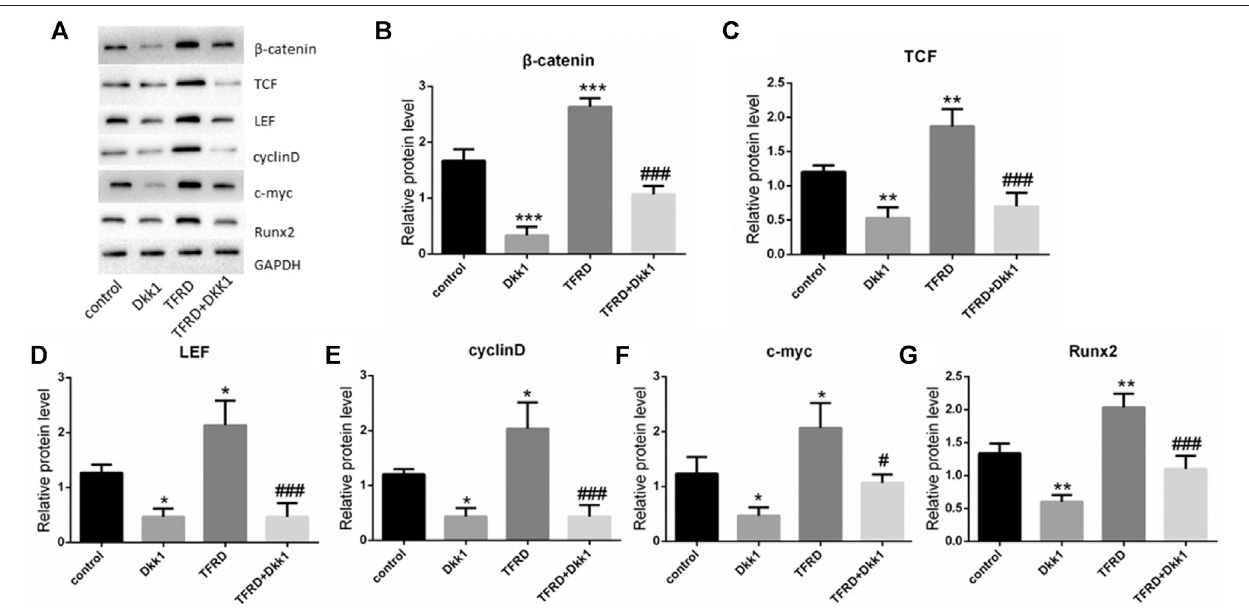
FIGURE 4 | EffectofTFRD on proteinsrelated to Wnt/ β -catenin signaling pathway in osteoblasts. (A) The relative protein expression levels of β -catenin, TCF, LEF, cyclinD,c-mycandRunx2weredetectedbyWesternblot. (B – G) Semiquantitativeanalysisofproteinexpression.N (cid:2) 3/group.Eachvaluewaspresentedasthemean ±